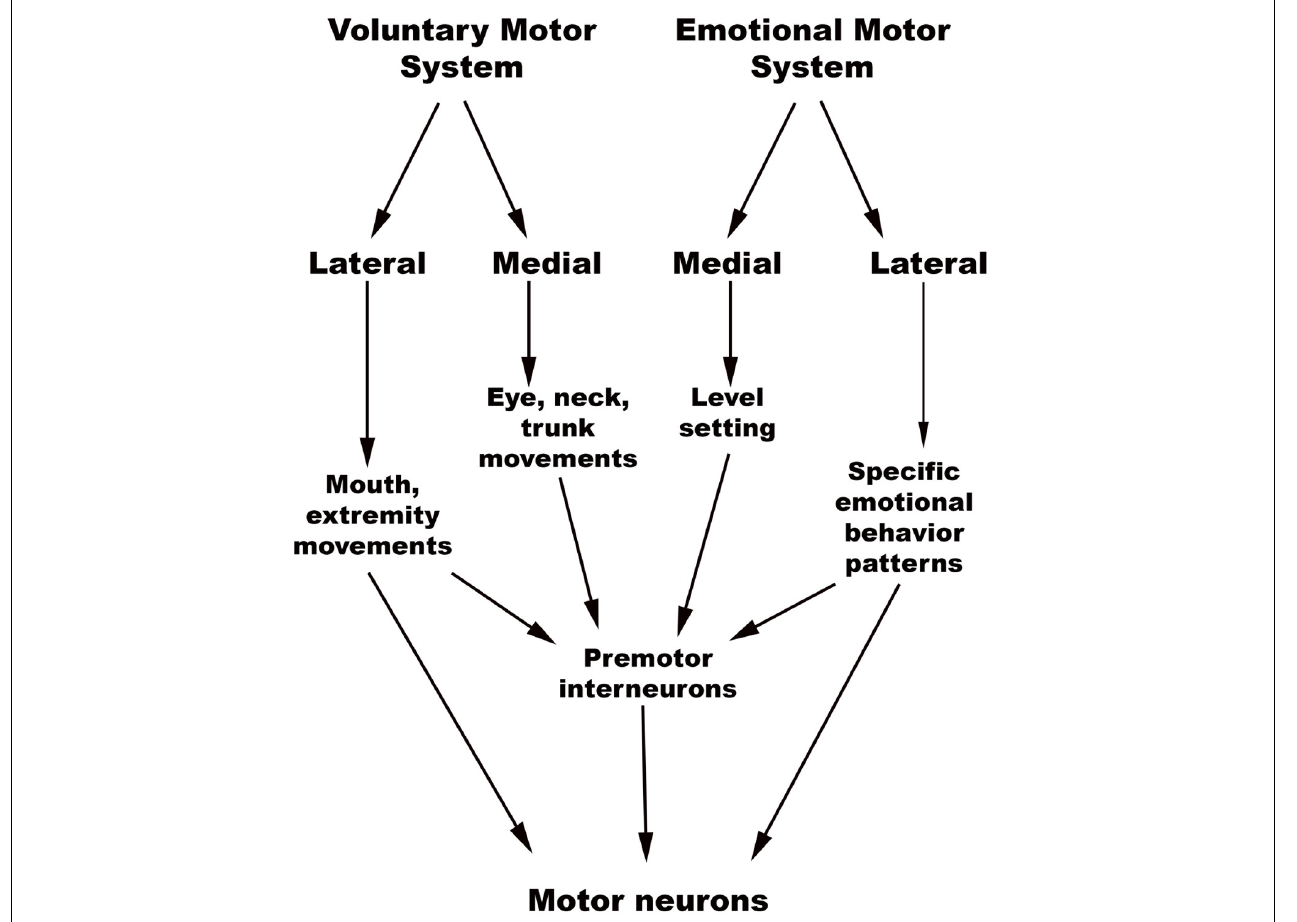
FIGURE 3 | Holstege’s conception of the Emotional and Somatic motor systems. (Adapted from Holstege, 2016).